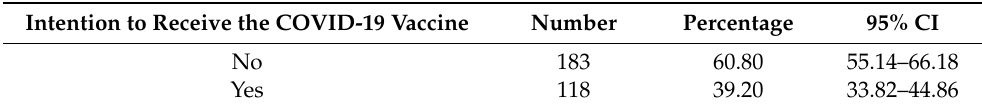
Table 4. Number, percent, and 95% confidence interval of Myanmar migrant workers who wanted to receive the COVID-19 vaccine within a year ( n = 301).